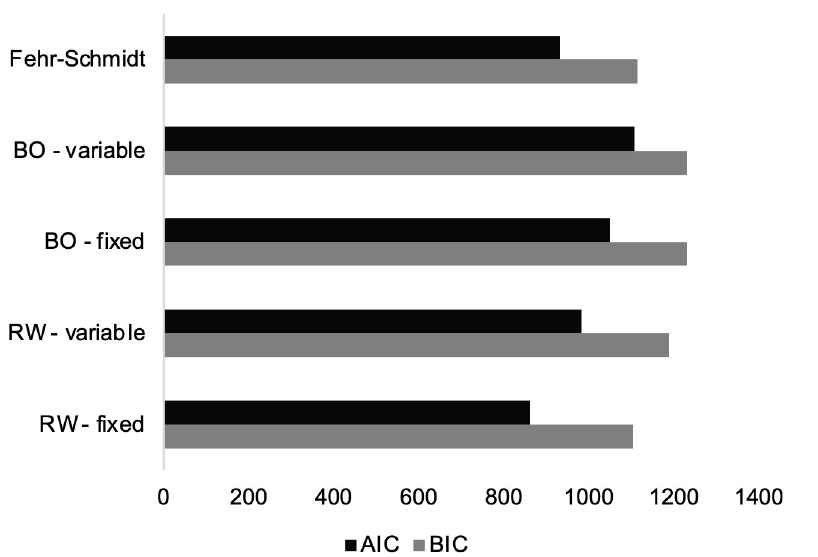
Fig 3. Sum BIC and AIC scores for behavioral